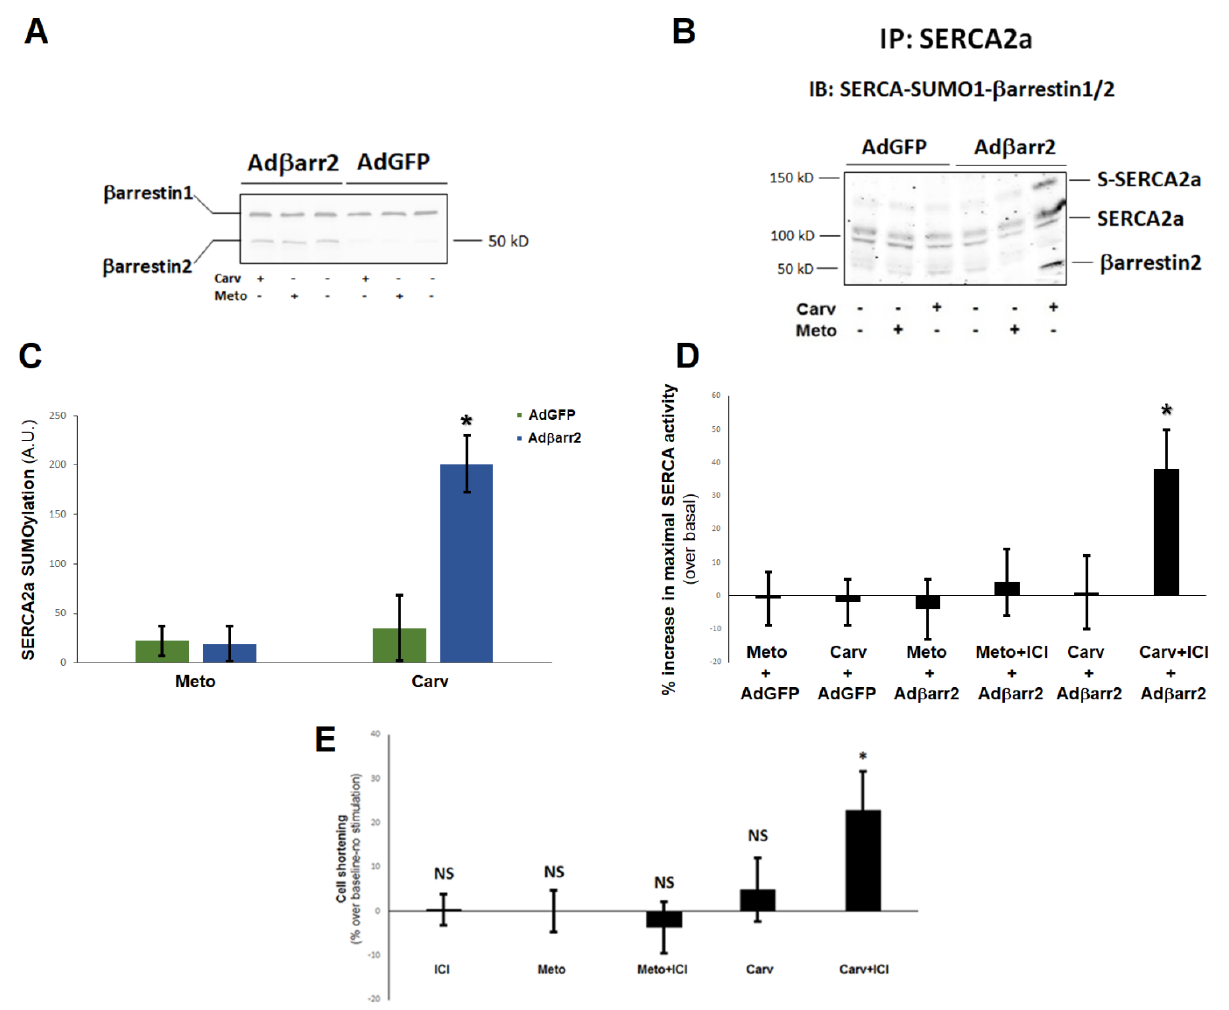
Figure 3. β -blockers and β arrestin2-dependent SERCA2a function and contractility in NRVMs. ( A ) Immunoblotting for β arrestins in control (AdGFP) or in NRVMs expressing β arrestin2 (Ad β arr2) to confirm β arrestin2 transgene induction. Like H9c2 cardiomyocytes, NRVMs also appear to express only β arrestin1 endogenously at detectable levels (see AdGFP lanes). Shown is a representative blot from three independent experiments. ( B , C ) Immunoblotting for β arrestins, SUMO1 and SERCA2a in SERCA2a IPs prepared from these cells and treated with vehicle (0.1% DMSO), 1 μM carvedilol (Carv), or 1 μM metoprolol (Meto) for 20 min. Representative blots are shown in ( B ) and SERCA2a SUMOylation quantitation, as measured by densitometry, is shown in ( C ). S-SERCA2a: SUMOylated SERCA2a; A.U.: Arbitrary (densitometric) units. As in H9c2 cardiomyocytes, only β arrestin2 could be detected in SERCA2a IPs and only in Ad β arr2-infected cells treated with carvedilol. * , p < 0.05, vs. any other treatment/cell clone; n = 3 independent experiments. ( D ) Maximal SERCA activity potentiation in microsomes isolated from β arrestin2-expressing (Ad β arr2) or control (AdGFP) NRVMs. ICI: 10 μM ICI 118,551; Meto: 1 μM metoprolol; Carv: 1 μM carvedilol, for 30 min. * , p < 0.05, vs. any other group; n = 3 independent measurements/transfection group/treatment. ( E ) Cell shortening response of β arrestin2-overexpressing NRVMs treated as in ( D ). * , p < 0.05, vs. any other treatment; NS: Not significant vs. basal (0.1% DMSO) at p = 0.05; n = 3 independent measurements (in triplicate)/treatment